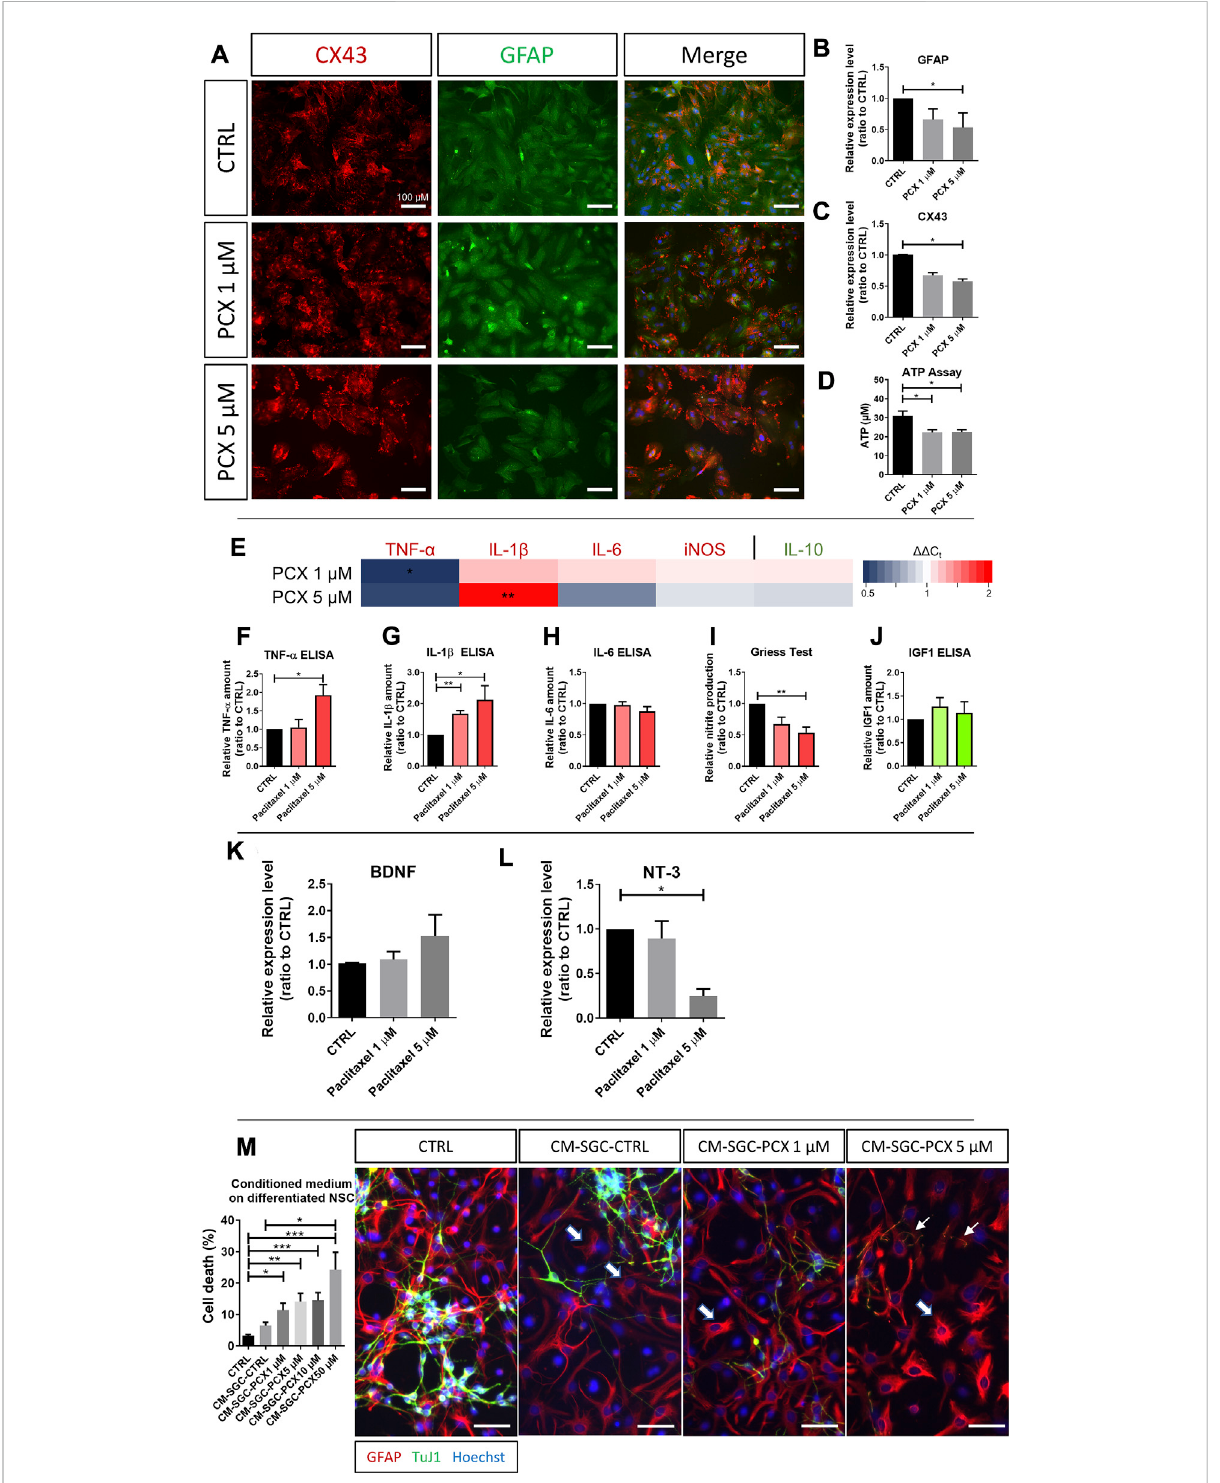
FIGURE 2 Effects of paclitaxel on satellite glial cells. (A) Immuno fl uorescence micrographs of Connexin 43 (CX43) and glial fi brillary acidic protein (GFAP) in satellite glial cells (SGC) after no treatment or exposure to 1 μ M and 5 μ M paclitaxel (PCX). (B) Relative expression level of GFAP in SGC after 1 μ M and5 μ Mpaclitaxel exposure comparedto control (n (numberofindependentcell culturepreparations)= 3). (C) Relative expressionlevel of CX43in SGC after 1 μ M and 5 μ M paclitaxel exposure compared to control (n (number of independent cell culture preparations) = 3). (D)